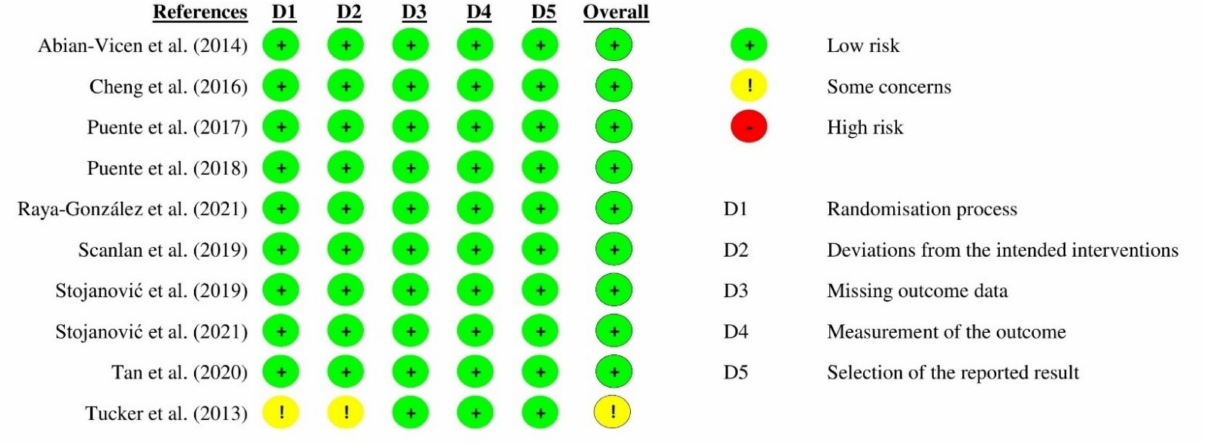
Figure 2. Cochrane Risk-of-Bias (RoB 2) tool. Table 1. Physiotherapy Evidence Database (PEDro)